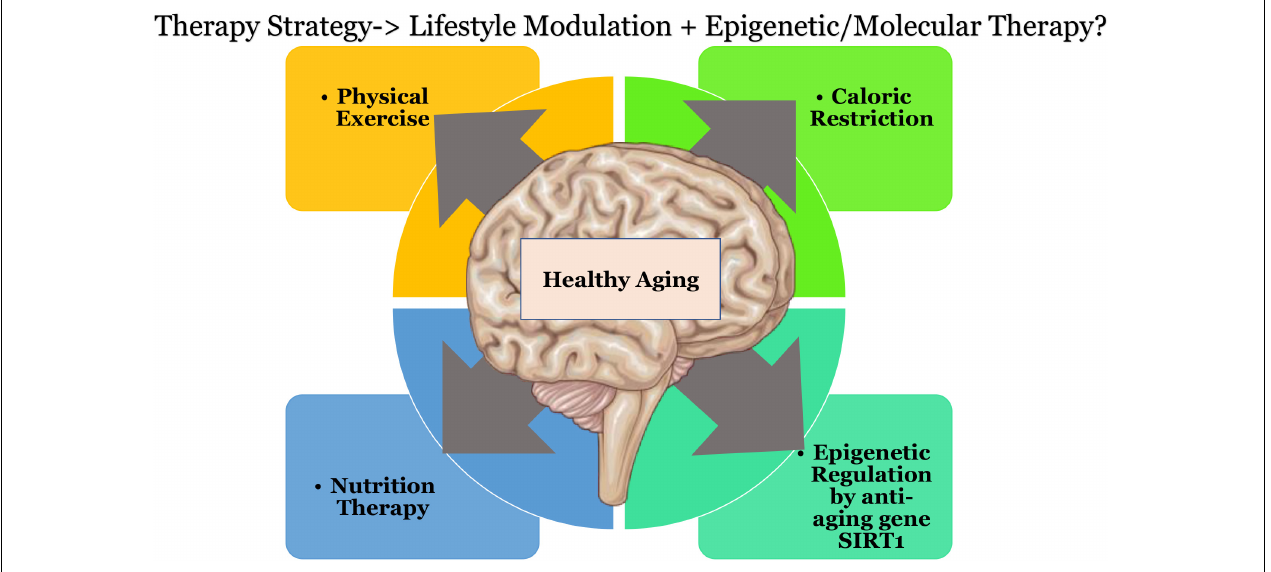
FIGURE 2 | Possible therapeutic directions that could result in healthier aging of the brain. Schematic parts of the figure were taken from Servier Medical art (https://smart.servier.com/) licensed under an Unported license of Creative Commons Attribution 3.0.